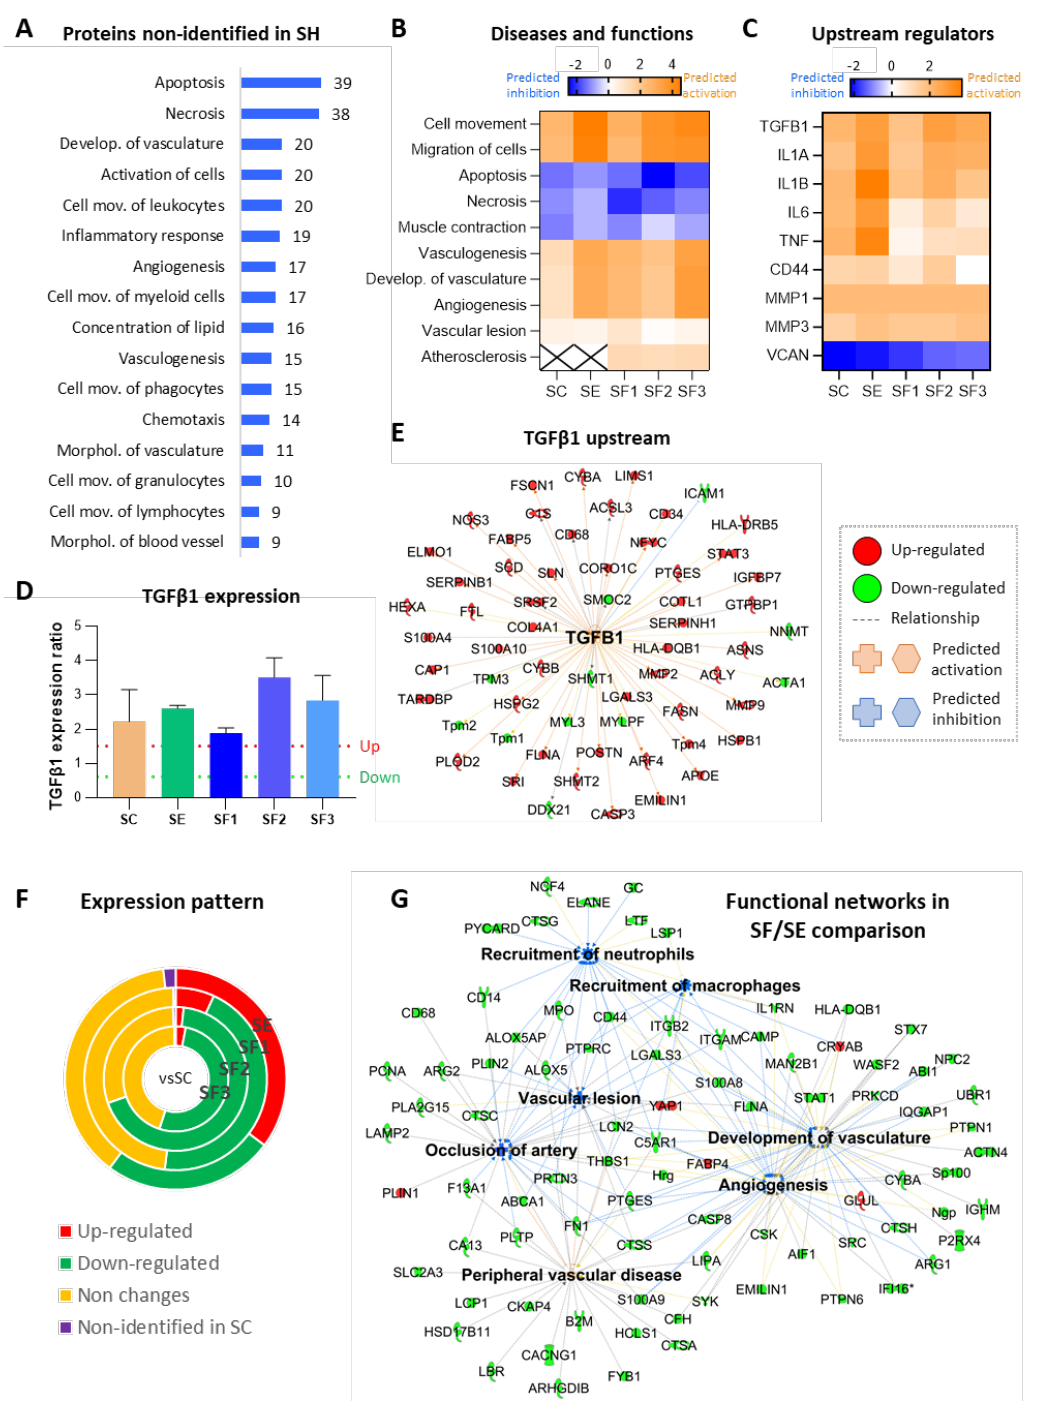
Figure 3. Proteomic changes in response to ischemia and long-term treatment with CACs. ( A ) Functional classification of proteins not identified in SH mice. The classification was made with IPA, which also provided the heat maps shown in ( B ) with the major functions and diseases and ( C ) upstream regulators related to proteins differentially expressed in SC, SE, and SF vs. SH (based on z-scores probability values). ( D ) TGFβ1 levels were analyzed by ELISA in muscle limbs on day 21. ( E ) IPA functional network built with TGFβ1 -related proteins related which were altered in response to ischemia (SC, SE, and SF, vs. shams). ( F ) Circular chart representing the percentage of proteins altered in CACs-treated (SE and SF) vs. un-treated SC mice. ( G ) IPA functional network including the major functions correlated with the proteins differentially expressed in SF vs. SE. Groups analyzed: Sham, surgery controls (SH, n:4); ischemic mice, untreated (SC, n:5): ischemic mice with unstimulated CACs (SE, n:6) or pre-stimulated with atherosclerotic factors (SF: n:15: SF1, n:5; SF2, n:5; SF3, n:5).